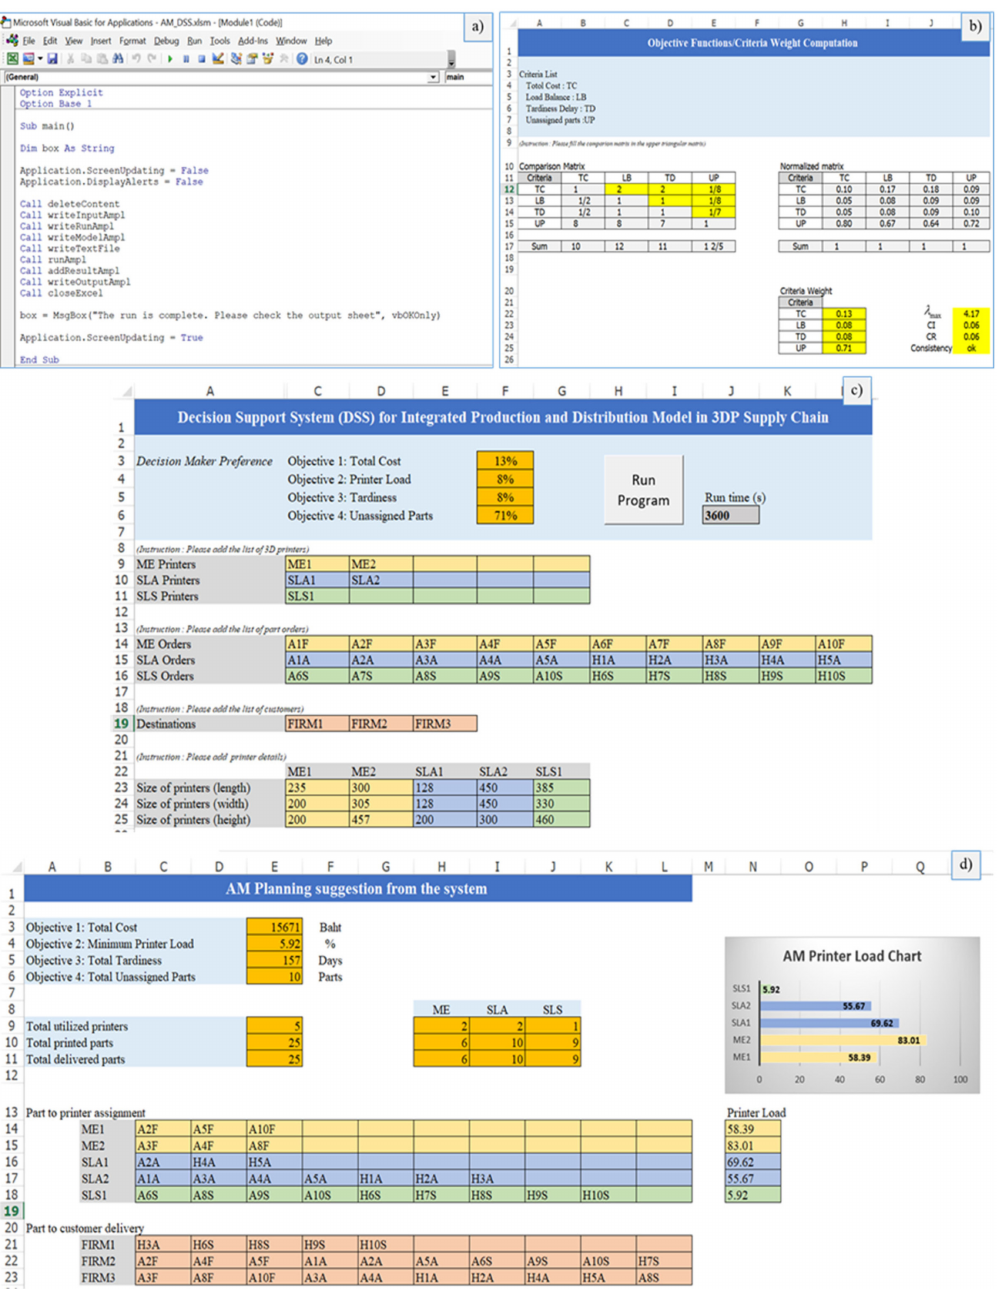
Figure 3. Screenshots of the decision-support tool: ( a ) Visual Basic development, ( b ) AHP weight synthesis, ( c ) input sheet using the AHP weights, and ( d ) output